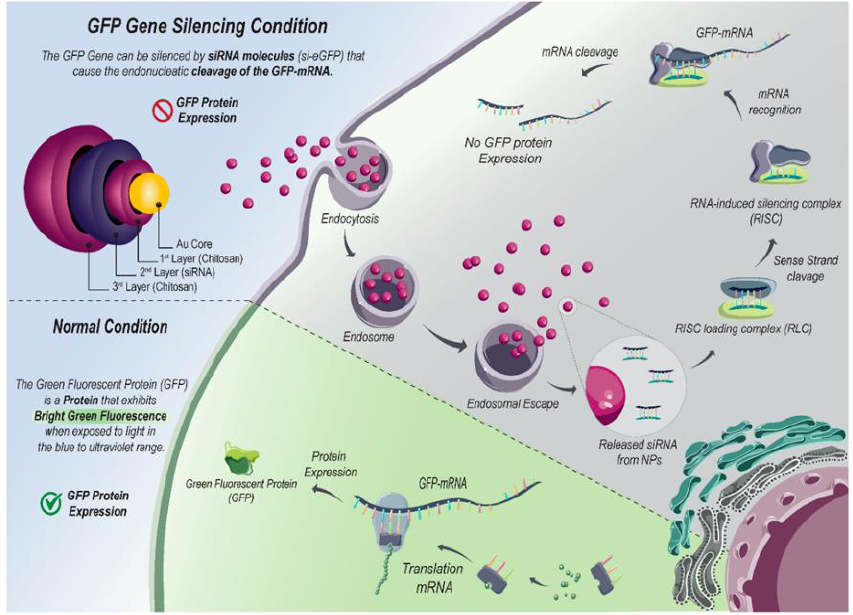
Figure 3. Schematic representation of the chitosan-coated AuNPs for siRNA delivery [99].